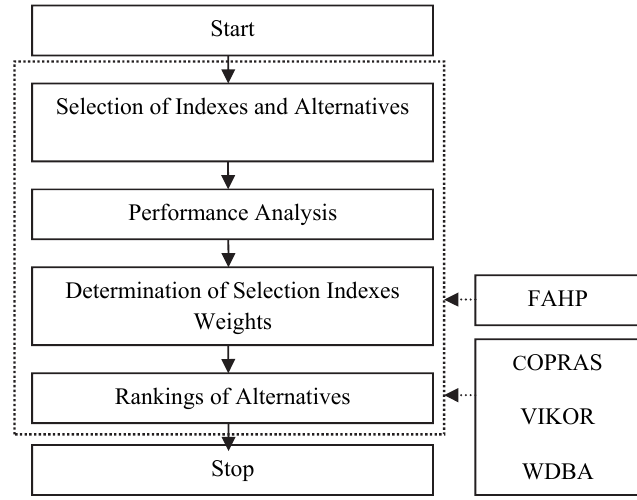
Fig. 1. Proposed evaluation